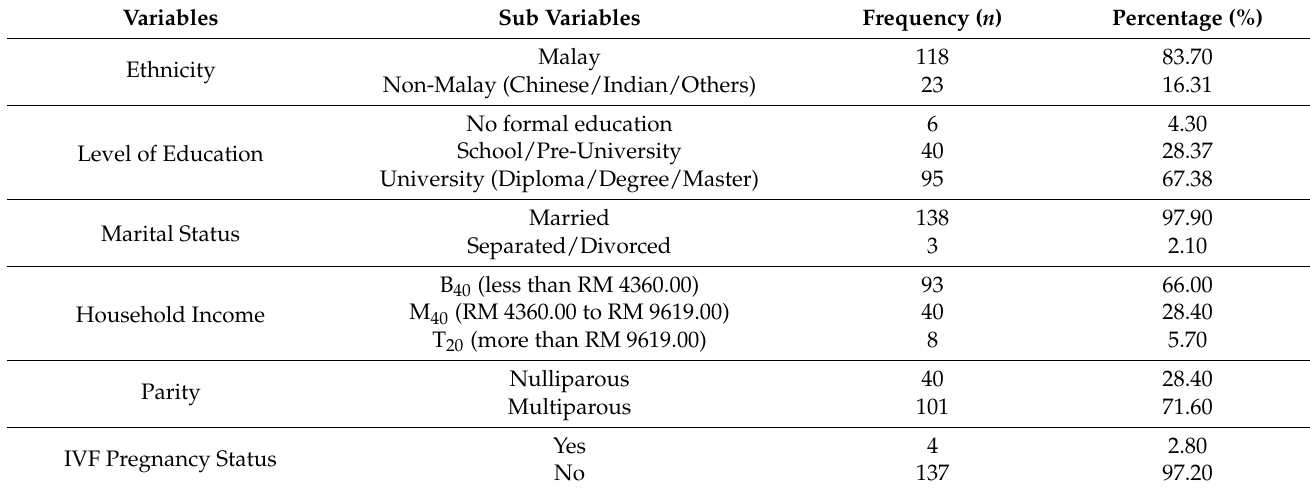
Table 1. Participants’ profile ( n =